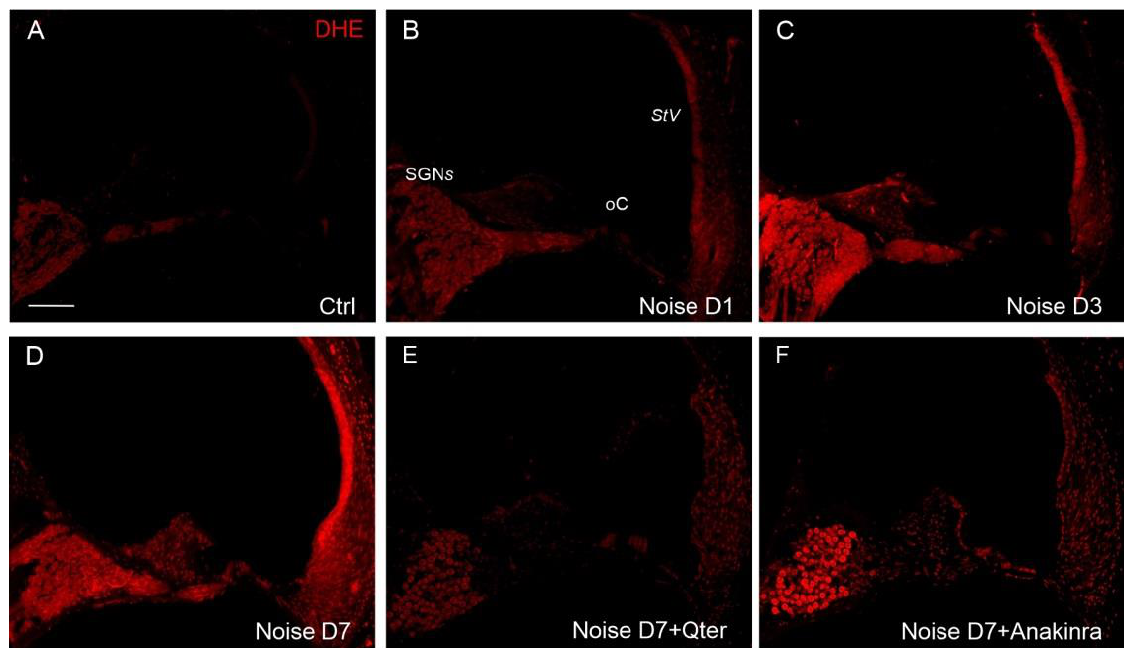
Figure 7. Cochlear ROS amount in Q-ter and Anakinra treated animals. Representative images of cochlear cryosections stained with DHE (red fluorescence). Superoxide fluorescence is faint in the control group ( A ). In the Noise group, DHE fluorescence progressively increases from day 1 to day 7 ( D1 – D7 ) in all cochlear structures ( B – D ). Q-ter supplementation decreases superoxide expression in all cochlear structures ( stria vascularis , organ of Corti and SGNs) ( E ), whereas Anakinra treatment attenuates ROS amount in the organ of Corti and stria vascularis , with a poor protective effect in SGNs ( F ). StV: stria vascularis ; oC: organ of Corti; SGNs: spiral ganglion neurons. Scale bar: 100 μM.